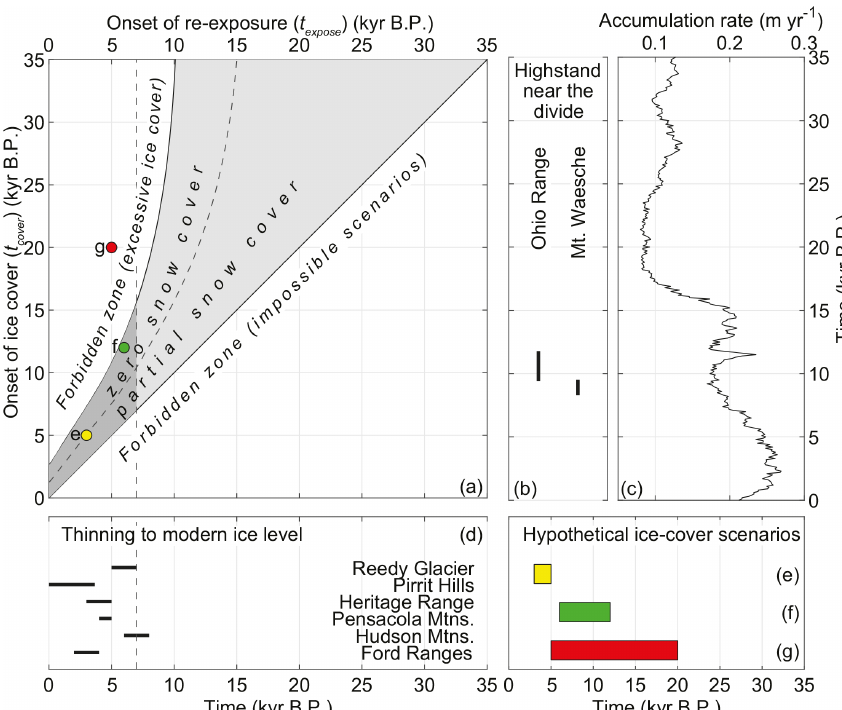
Figure 6. (a) Chronological constraints on exposure and ice cover of the two bedrock samples within ∼ 30m of the modern ice surface at Mt. Seelig. Scenarios that plot in the gray regions are permitted by the 14 C concentrations. The lower right half of the diagram represents impossible scenarios because reexposure cannot occur prior to ice cover; the white area on the left side of the diagram shows scenarios that are forbidden because they underpredict the observed 14 C concentrations. The gray areas left of the curved dashed line assume that less-than-saturated 14 C concentrations are only due to cover by WAIS thickening, while the areas to the right allow for the possibility that the samples experienced cover by a combination of a thicker WAIS and expanded snow fields. The position of these regions accounts for 1 σ measurement uncertainties of both samples. The 1 : 1 line represents end-member scenarios of zero ice-sheet cover, which are permitted by the 14 C data. The three circles correspond to the hypothetical ice cover scenarios shown in panels (e) – (g) . (b) Timeline showing when ice was at a highstand at the Ohio Range and at Mt. Waesche, sites near the WAIS Divide, based on exposure dating of glacial deposits (Ackert et al., 1999, 2007, 2013). Note that the highstands could have begun before and/or persisted after the ages shown. (c) The accumulation-rate record from the WAIS Divide ice core (Fudge et al., 2016). (d) Timeline showing when modern ice levels were established at nunatak sites in West Antarctica. The vertical dashed lines in panels (a, d) represent the earliest time (7kyrBP) that the modern ice level could have been reached at the Whitmore Mountains, which is based on constraints from Reedy Glacier, the Pirrit Hills, and the Heritage Range, sites that share similar flow paths to the Whitmore Mountains. The dark gray region in panel (a) represents scenarios that are both (i) permitted by the 14 C concentrations and (ii) consistent with the constraints shown in panel (d) . (e) – (g) Timelines showing hypothetical burial intervals of the lowest two Mt. Seelig samples, which correspond to the circles in panel (a)